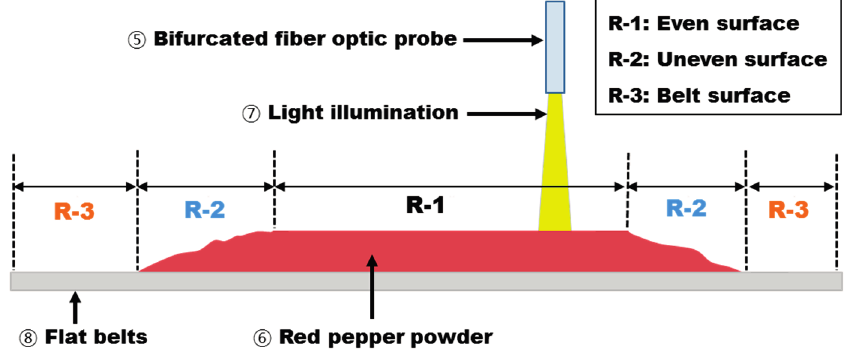
Figure 12. A schematic view of the condition for absorbance spectra acquisition.